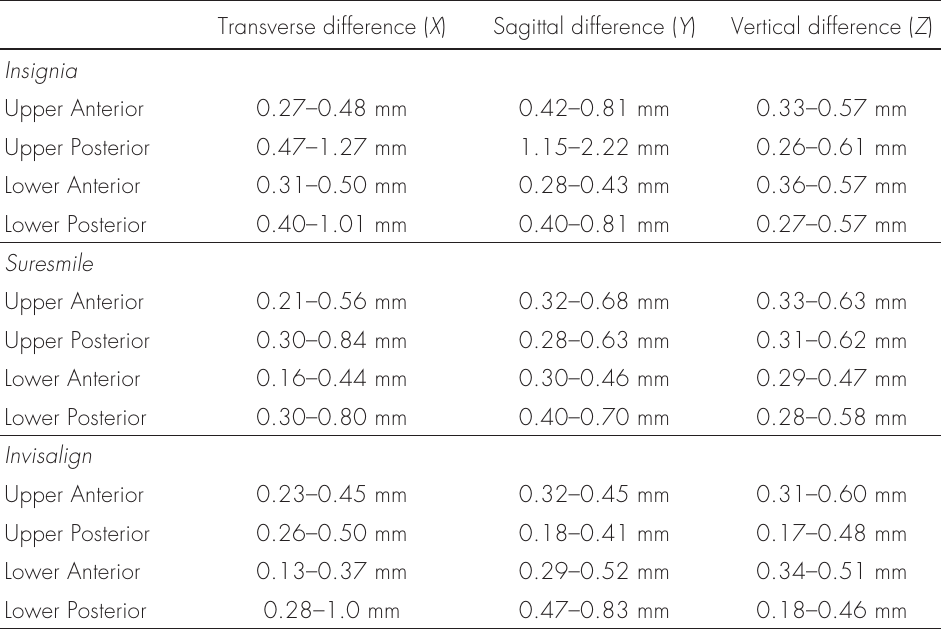
Table VII. Ranges of mean difference between predicted and actual loctions of Anterior & Posterior